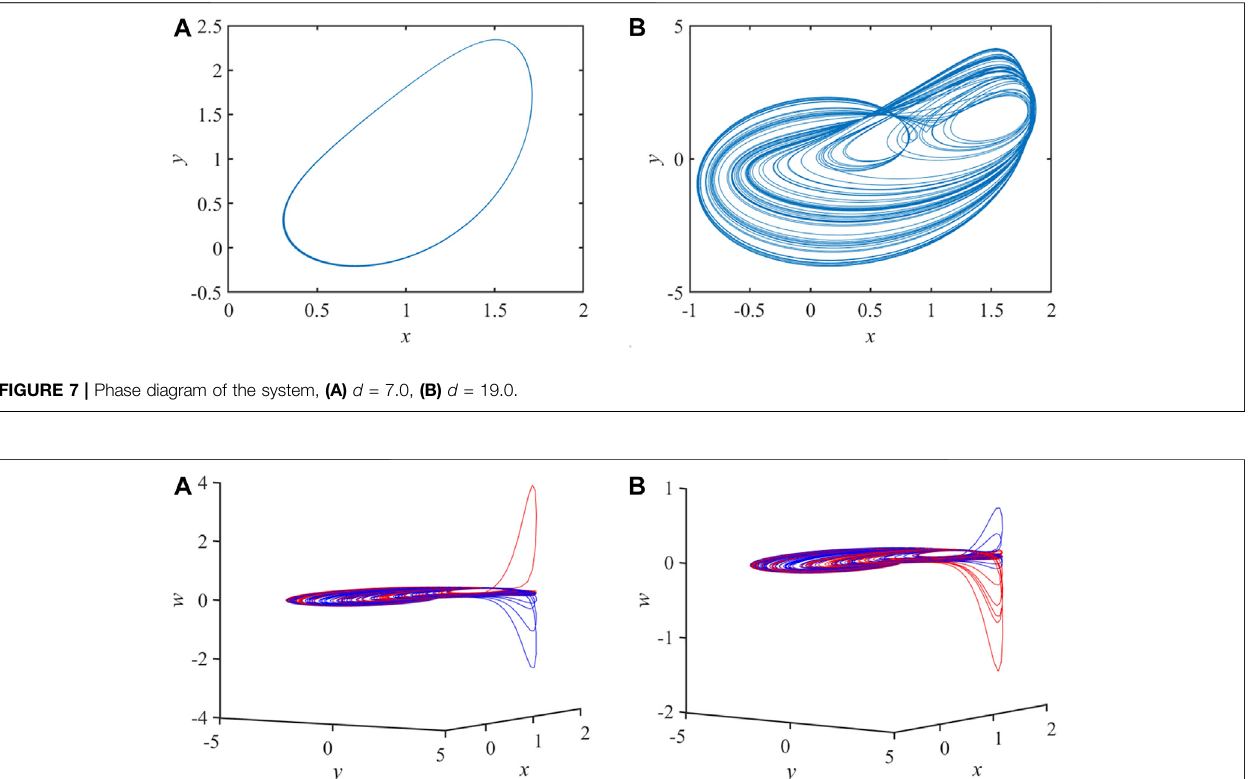
Frontiers in Physics |